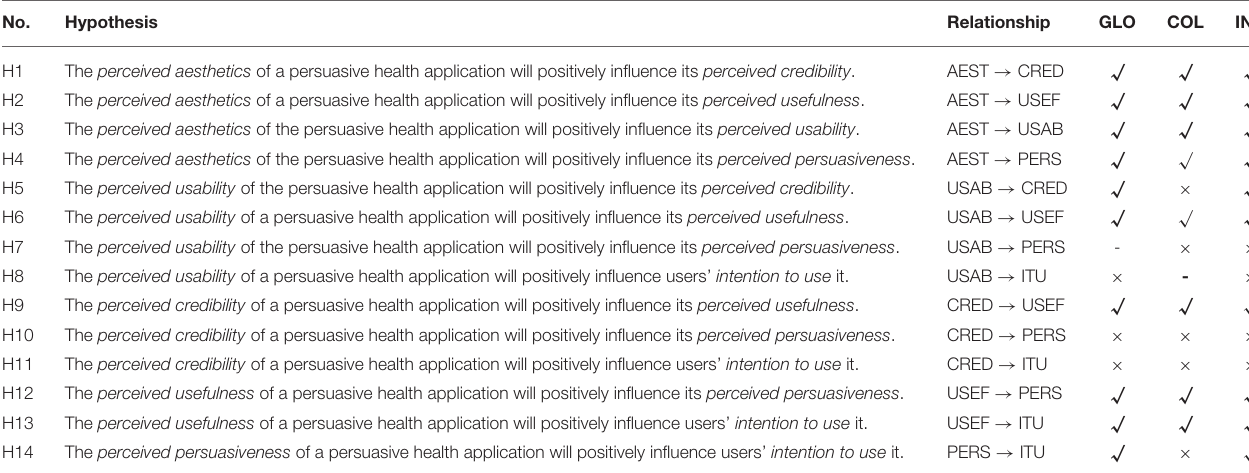
TABLE 5 | Summary of validated and non-validated